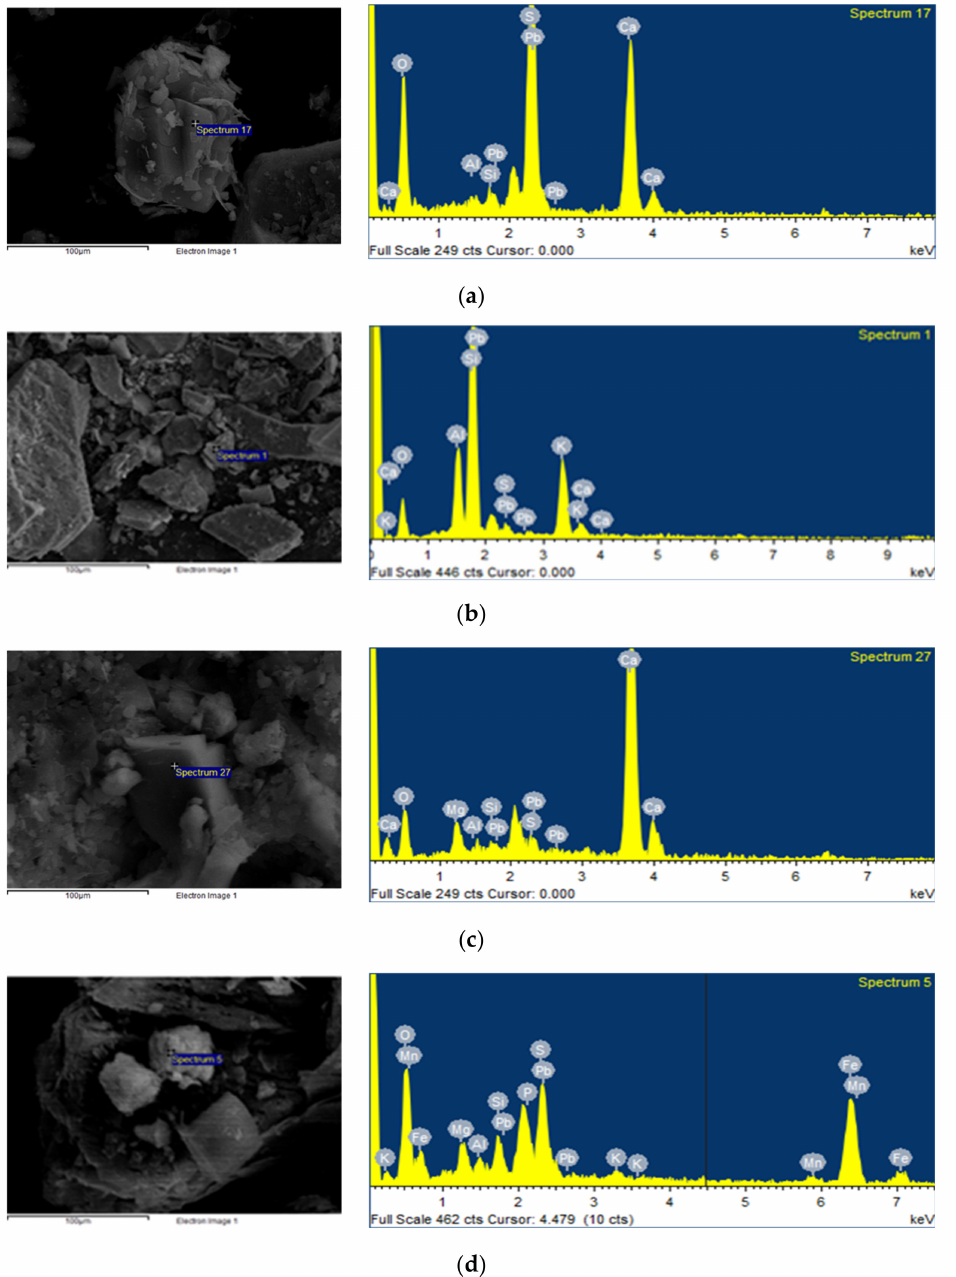
Figure 8. SEM-EDX analyses for the Pb in the contaminated soil treated with 10 wt% waste oyster shells (WOS) ( a ); calcined oyster shells (COS) ( b ); natural starfish (NSF) ( c ); and spent coffee grounds derived biochar (SCGB) ( d ) treated